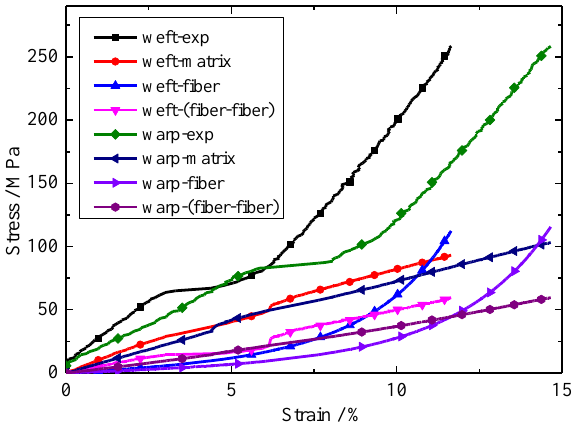
Figure 9. Relationship between the each constituent of stress and experimental stress with displacement under a stress ratio of 1:1 (warp:weft).